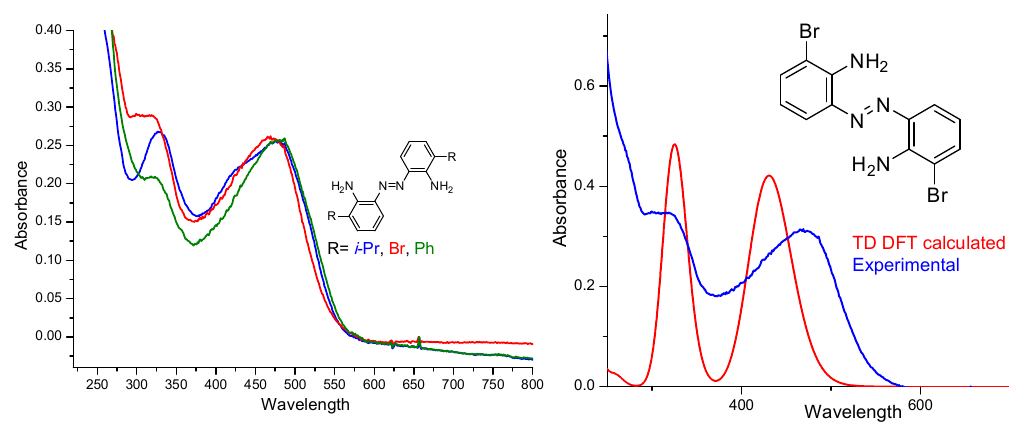
Figure 2 . UV-vis spectra of o-aminoazobenzenes D (R = i -Pr), E (R = Ph) and F (R = Br) with varying electronic substituents in solvent acetonitrile ( left ). TD-DFT calculated (blue) and experimental UV-vis spectra (red) of compound F ( right ).